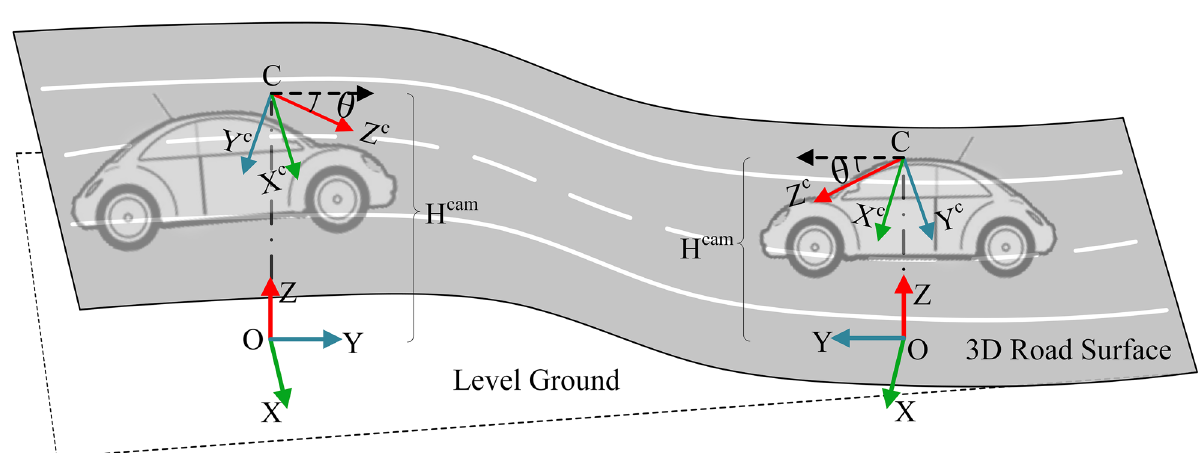
Figure 1. In-vehicle camera position and vehicle coordinate frame. This figure was drawn by author Qingbo